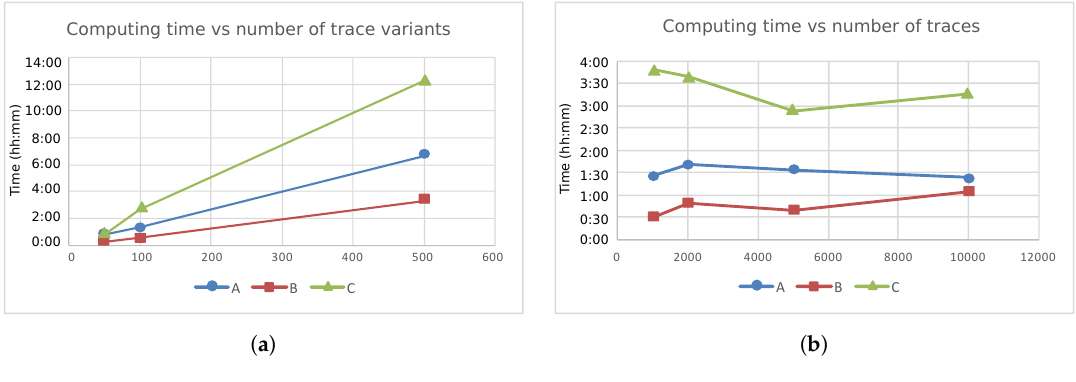
Figure 17. Performance of the genetic strategy when varying log complexity. ( a ) Trace variants complexity; ( b ) trace repetitions’ complexity.